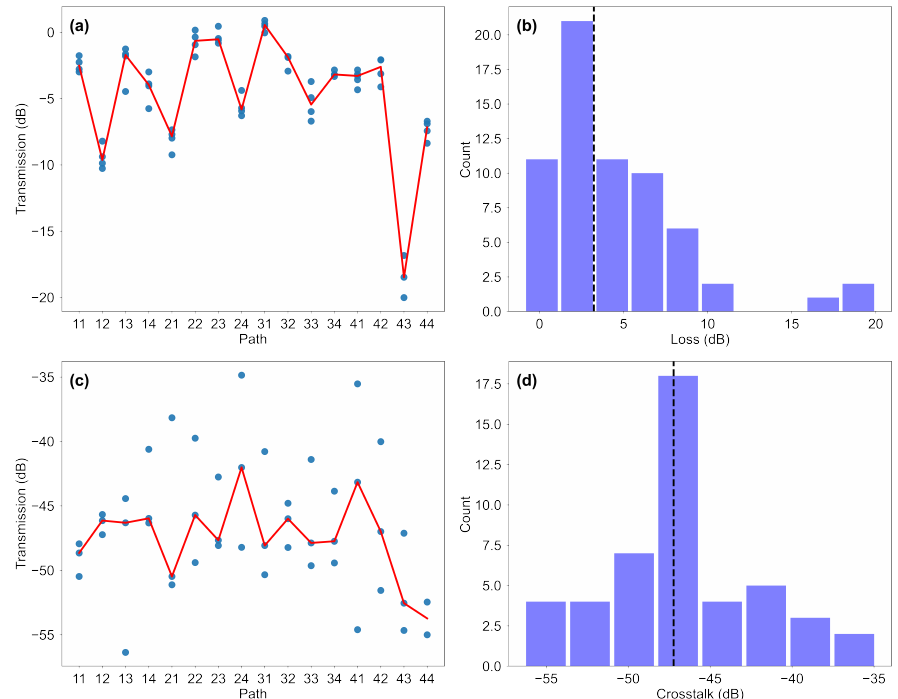
Figure 4. ( a ) Transmission (dB) vs. paths in the switch. Path 14 corresponds to input 1 and output 4. Each data point (blue) corresponds to measurement at a different wavelength. Red line corresponds to line connecting medians. ( b ) Histogram of Loss for different paths with a median of 5.32 dB. ( c ) CW crosstalk is measured at 1546.8 nm. This is the signal channel. ( d ) Worst case crosstalk is − 35